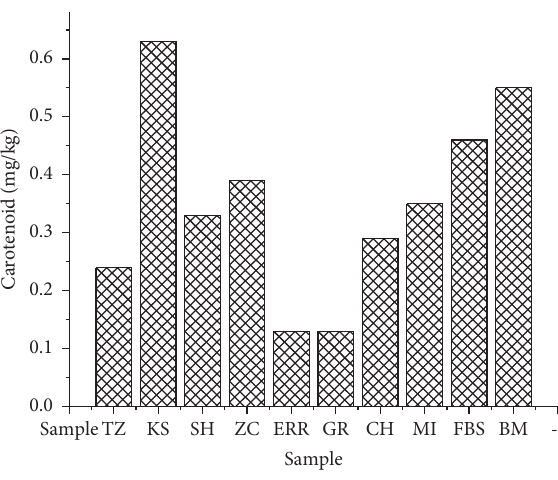
Figure 2: Carotenoid content of the studied samples. Figure 1: Chlorophyll content of the studied